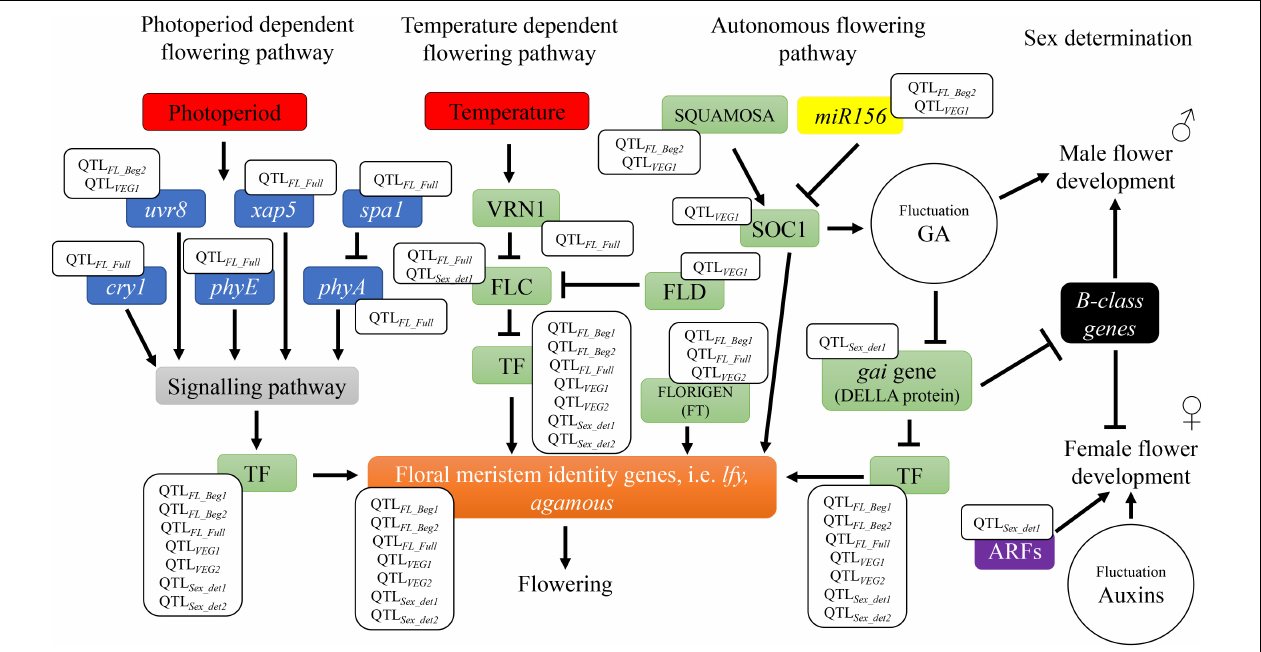
FIGURE 4 | Flowering and sex determination metabolic pathways: identification of candidate genes underneath the QTLs. The QTLs for flowering time are found in different flowering dependent pathways (photoperiod, temperature, and endogenous flowering pathways). Photoperiod pathway involves genes of the perception and transduction of light signals [ultraviolet-B receptors ( uvr8 ), circadian timekeeper ( xap5 ), suppressor of PHYA-105 ( spa1 ), cryptochromes ( cry1 ), phytochrome A ( phyA ), and phytochrome E ( phyE )]. Temperature pathway involves vrn1 , a vernalization dependent transcription factor. Both photoperiod and temperature pathways activate signaling pathways and/or transcription factors involved in the endogenous flowering pathway to regulate floral meristem identity genes, such as leafy ( lfy ). Genes that code for these transcription factors include flowering locus C (FLC), flowering locus D (FLD), flowering locus T (FLORIGEN or FT), s uppressor of overexpression of constans1 ( soc1 ), and gibberellic acid insensitive ( gai gene – DELLA protein), among others. TF is used to summarize all transcription factors inducing floral meristem identity genes. Endogenous pathway also include the regulatory element of flowering genes, miR156 . The QTLs for sex determination are found in metabolic pathways involved in regulation of phytohormones gibberellic acid (GA) or auxins. These pathways include B-class homeotic genes involved in the development of male flower organs and auxin response factors genes (ARFs) involved in female flower